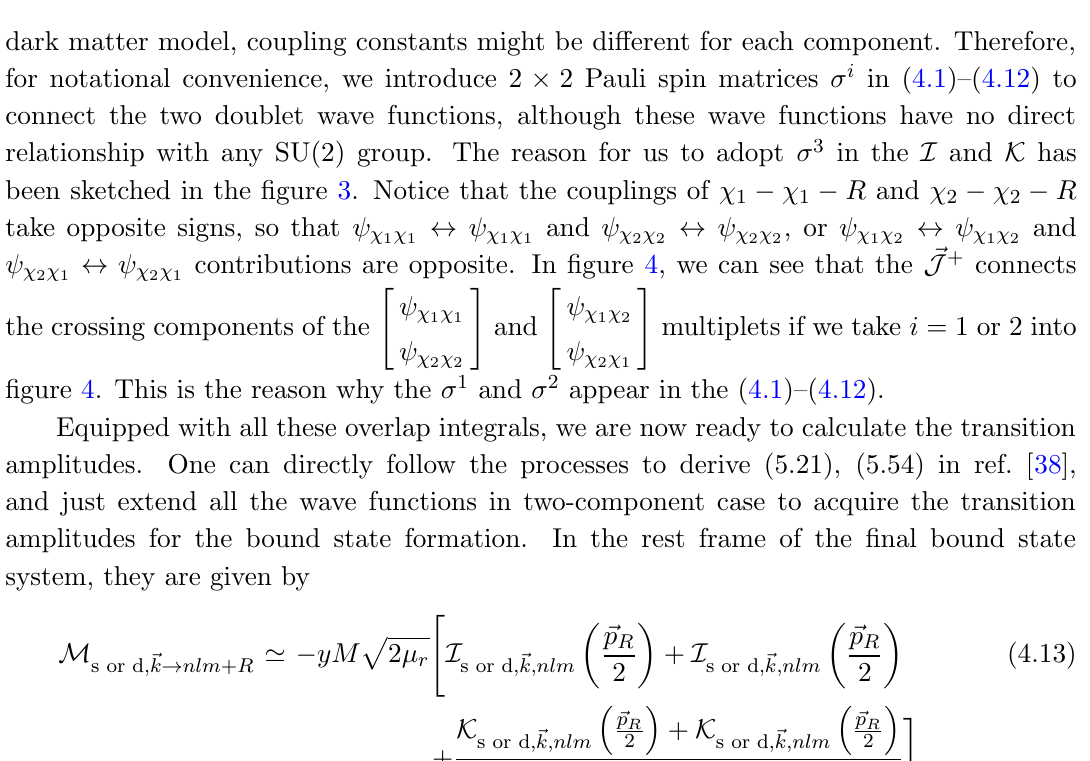
( x ) (cid:31) 1 nl ( x ) and (cid:31) (cid:3) ( x ) (cid:31) 2 nl ( x ) should also take the 1 l 2 ki 2 l 2 ki 1 1